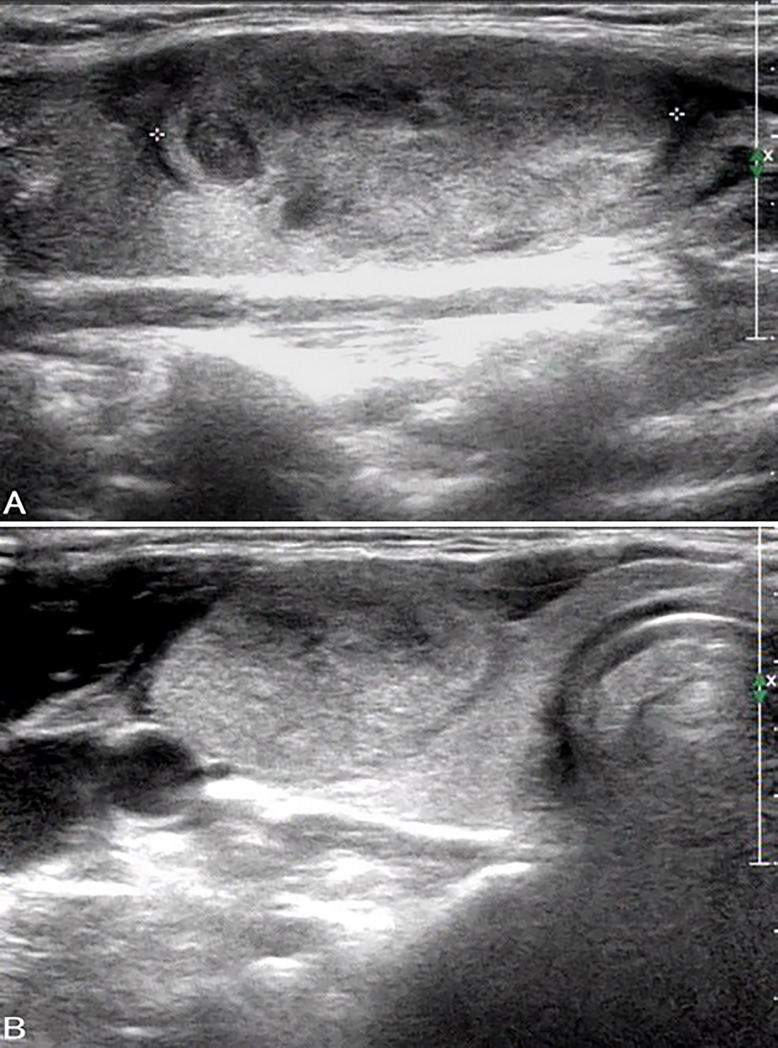
Ultrasound images in a patient with FTC in the right lobe.A, B. Longitudinal (A) and transverse (B) US show an isoechoic solid thyroid nodule (size: 33 mm × 15 mm × 24 mm) with wider-than-tall shape and ill-defined margins. The nodule was classified as ACR TIRADS category TR3. The cytological diagnosis was follicular neoplasm. FNA sample tested negative for K-RAS mutation while surgical specimen tested positive.